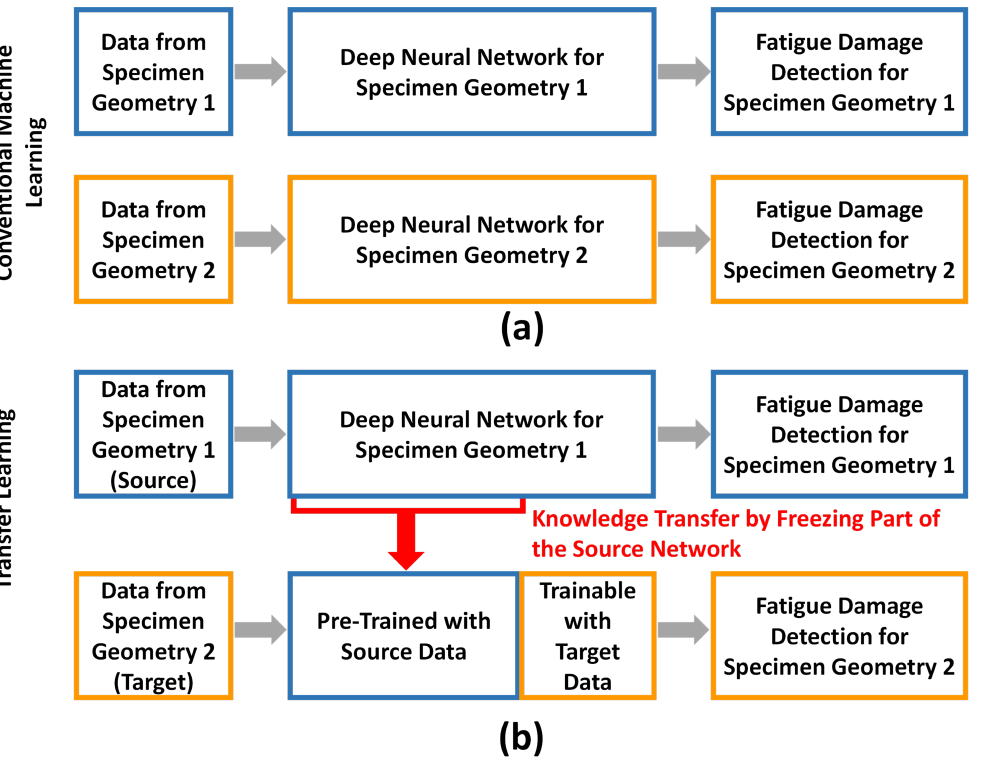
Figure 1. Schematic of ( a ) a conventional machine learning and ( b ) a transfer learning